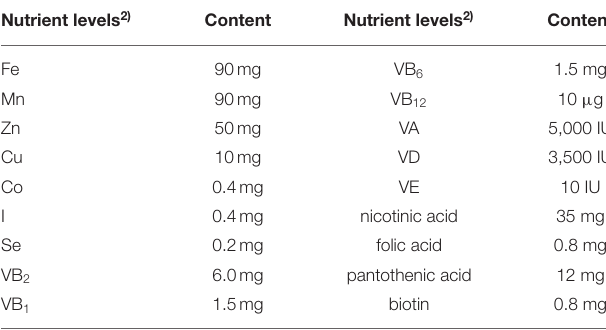
TABLE 2 | Nutrient level of premix (provided per kg of